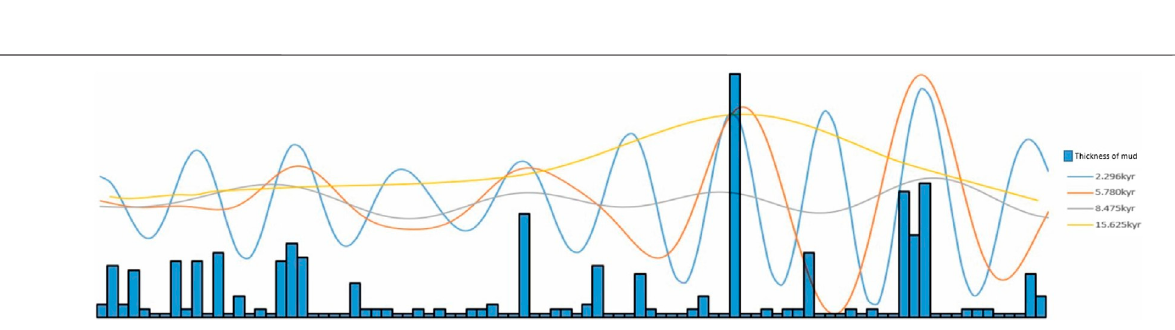
Frontiers in Earth Science |